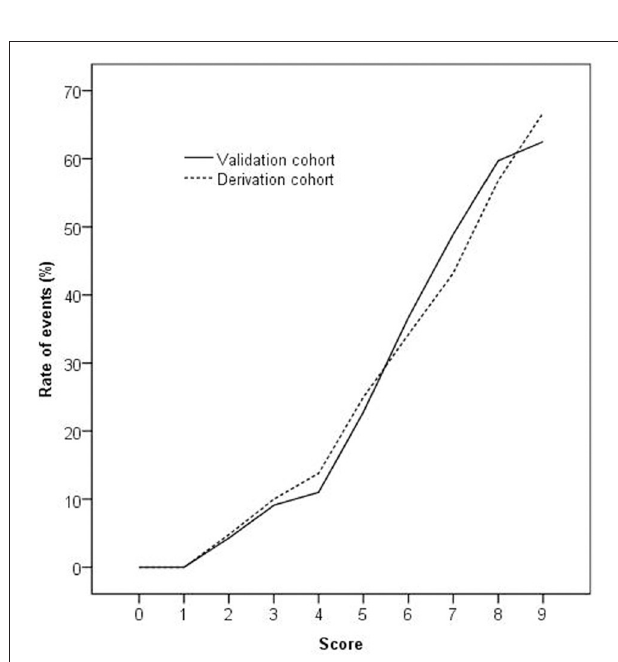
FIGURE 3 | The rate of events increased significantly as the score increased in the derivation and validation cohorts ( P < 0.001 by chi-square for trend). The slope of the increase in the event rates with an increasing score in the two cohorts was not statistically significant ( P = 0.879 by least-squares linear regression